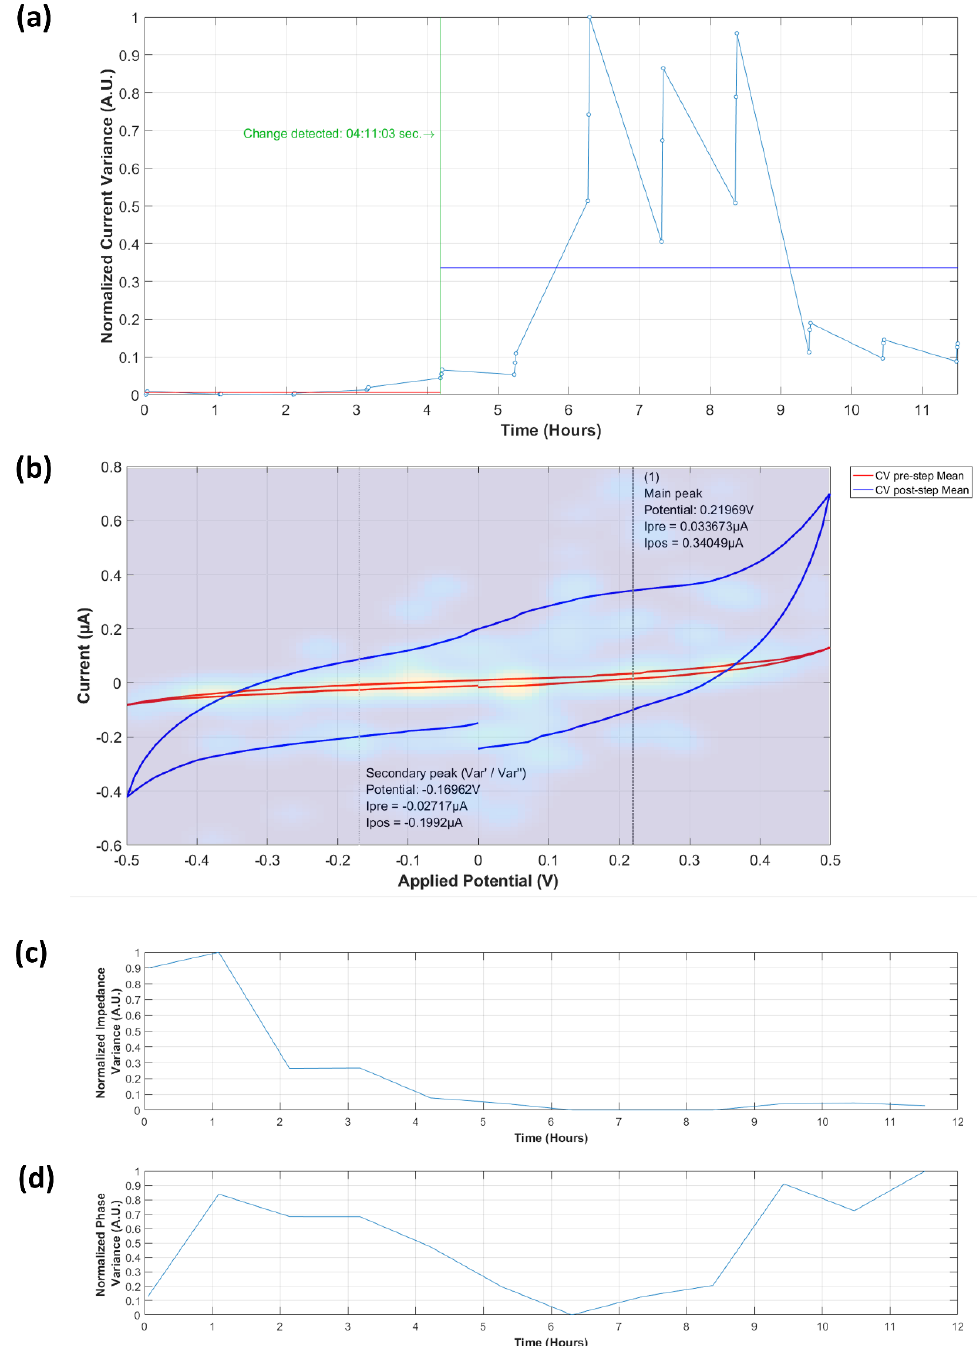
Figure A7 . Recorded electrochemical response of a colonized microsystem and electrode damage. ( a ) Normalized current variance vs. time. Detected current peaks are indicated (peaks from variance to its first derivative ratio are indicated as Var/Var’, peaks from first derivative to second derivative ratio are indicated as Var’/Var’’. The current values at each peak are indicated for the mean before colonization event as I pre and for the mean after colonization event as I pos ). ( b ) Recorded CV with calculated peaks and heatmap of detected peaks, where yellow represents a high concentration, and dark blue no peak. ( c ) Normalized impedance variance vs. time. ( d ) Normalized phase variance vs. time. Note that after the initial step-shaped curve, a sudden drop occurred in the current normalized variance, while no immediate change was seen in the impedance normalized variance, and an increase in the phase normalized variance occurred. These effects might be explained due to an increase in the microsystem contact resistance, while the faradaic effects in the microsystem are still present.